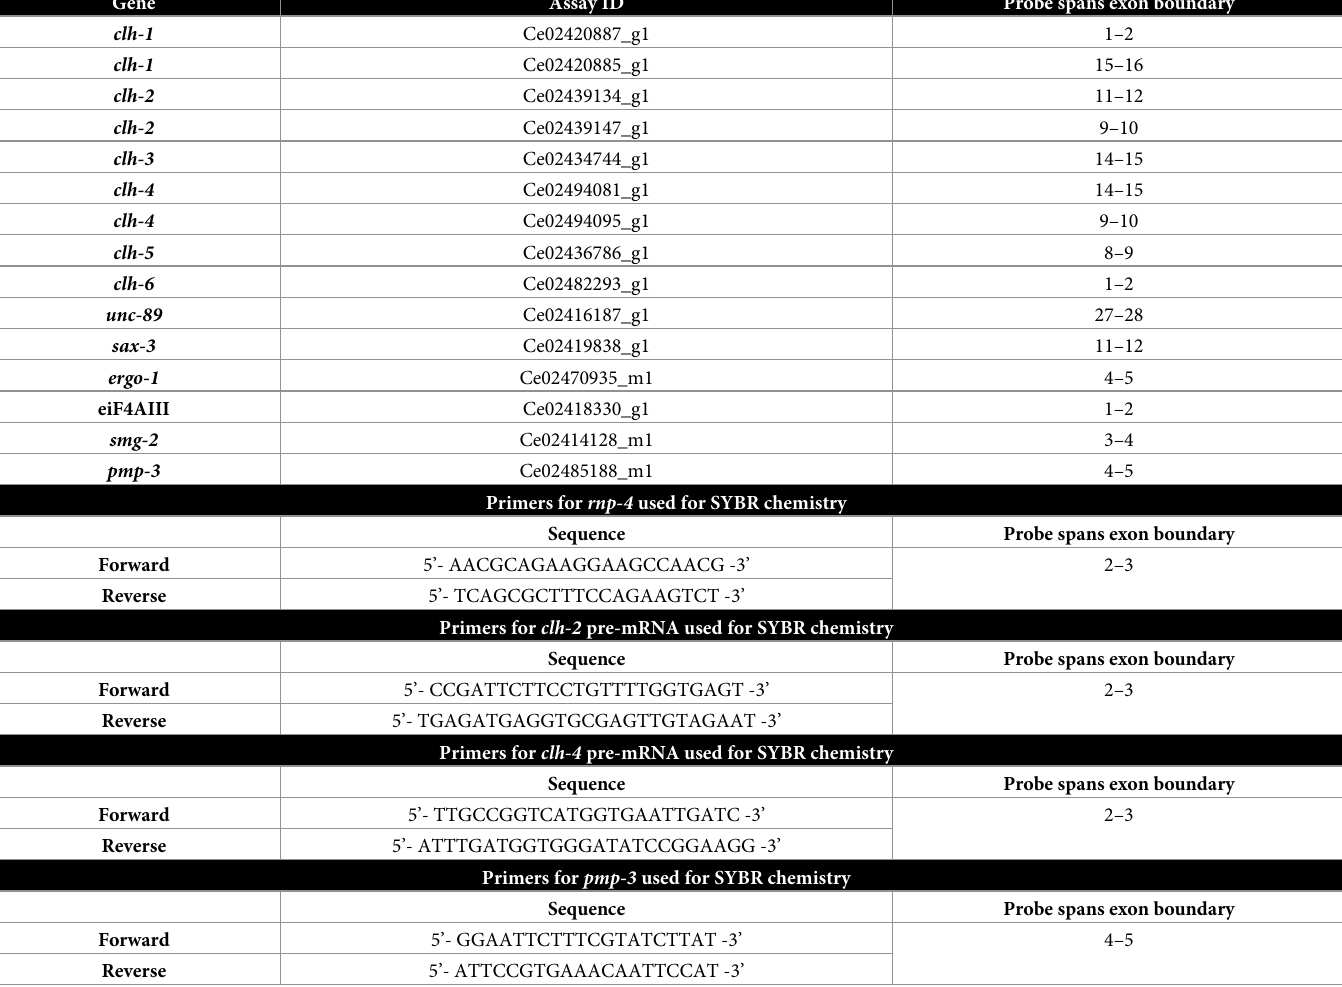
Table 4. Probes and primers used for qRT-PCR amplification for TaqMan and SYBR chemistries. We note that all probes selected span exon-exon junctions that are shared between different splice variants of the same clh gene, so they do not distinguish between splice variants.